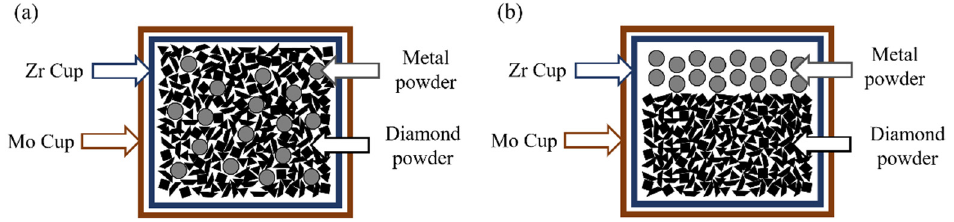
Figure 1. Schematic of powder assembly: ( a ) mixing-sintering method; ( b ) infiltration-sintering method.